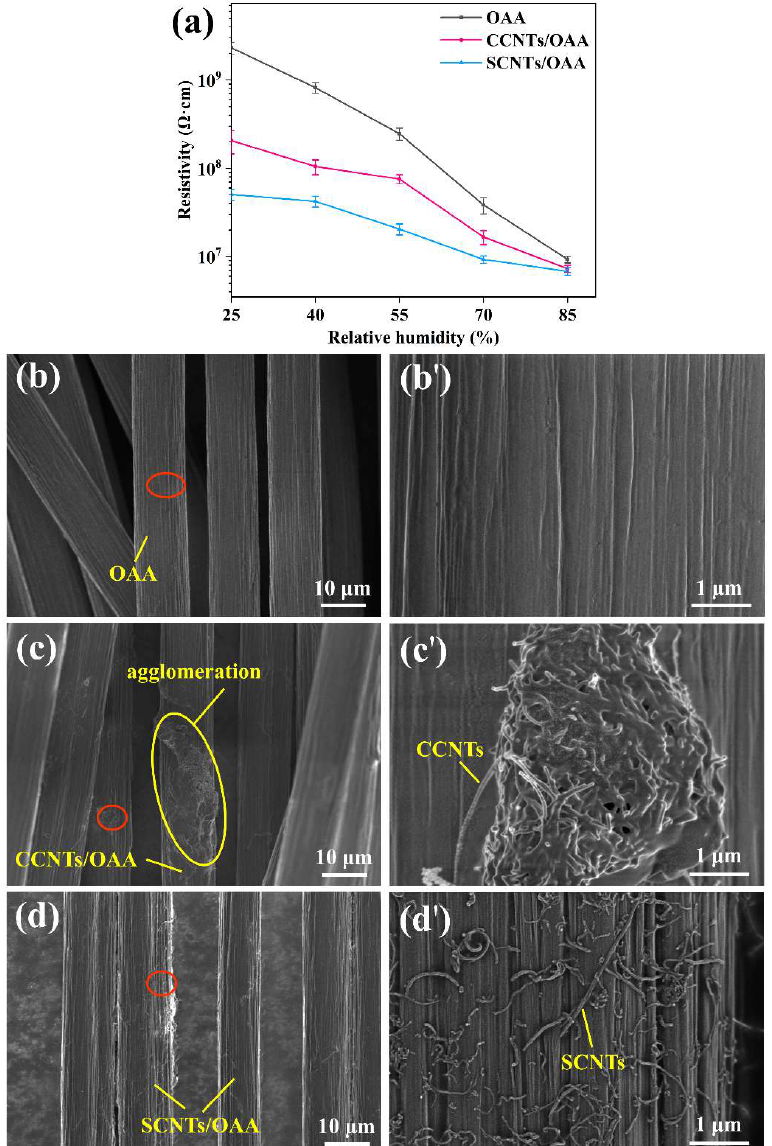
Figure 5. ( a ) Resistivity of fiber under different relative humidity; SEM images of fiber treated with ( b ) OAA, ( c ) CCNTs/OAA, and ( d ) SCNTs/OAA. ( b’ – d’ ) The enlarged images in the red circle.